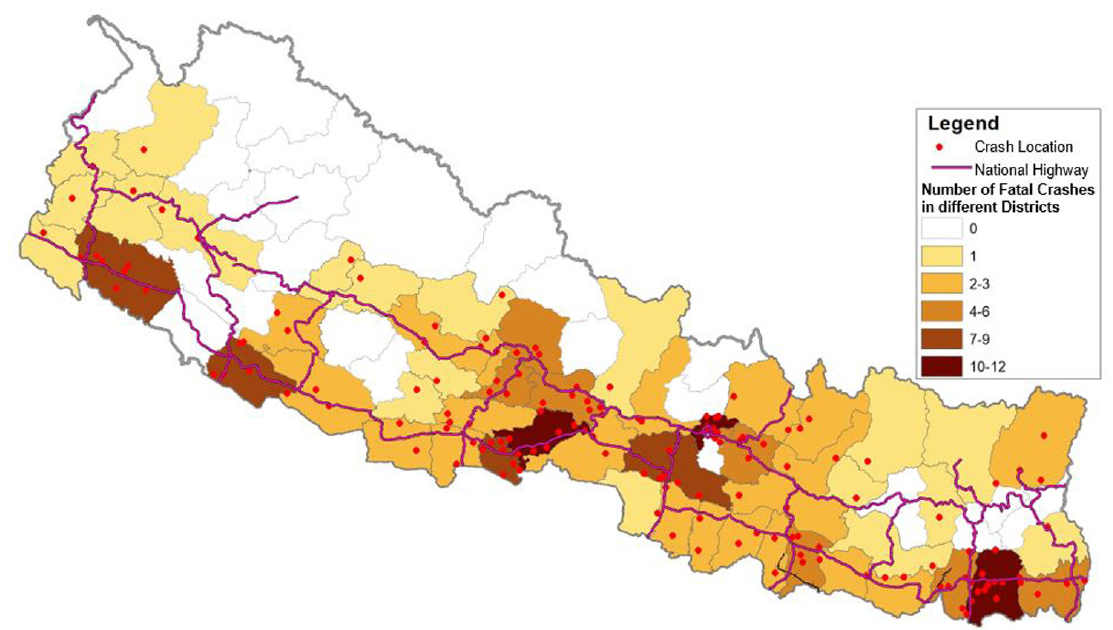
Figure 2. Visualization of road crashes deaths during COVID-19 lockdown reported in the media by Palika and national highways. Source: Locations of road crashes and fatalities from media reports. Map reproduced with the permission of the Survey Department of Nepal (2020) (Nepal Government Survey Department,